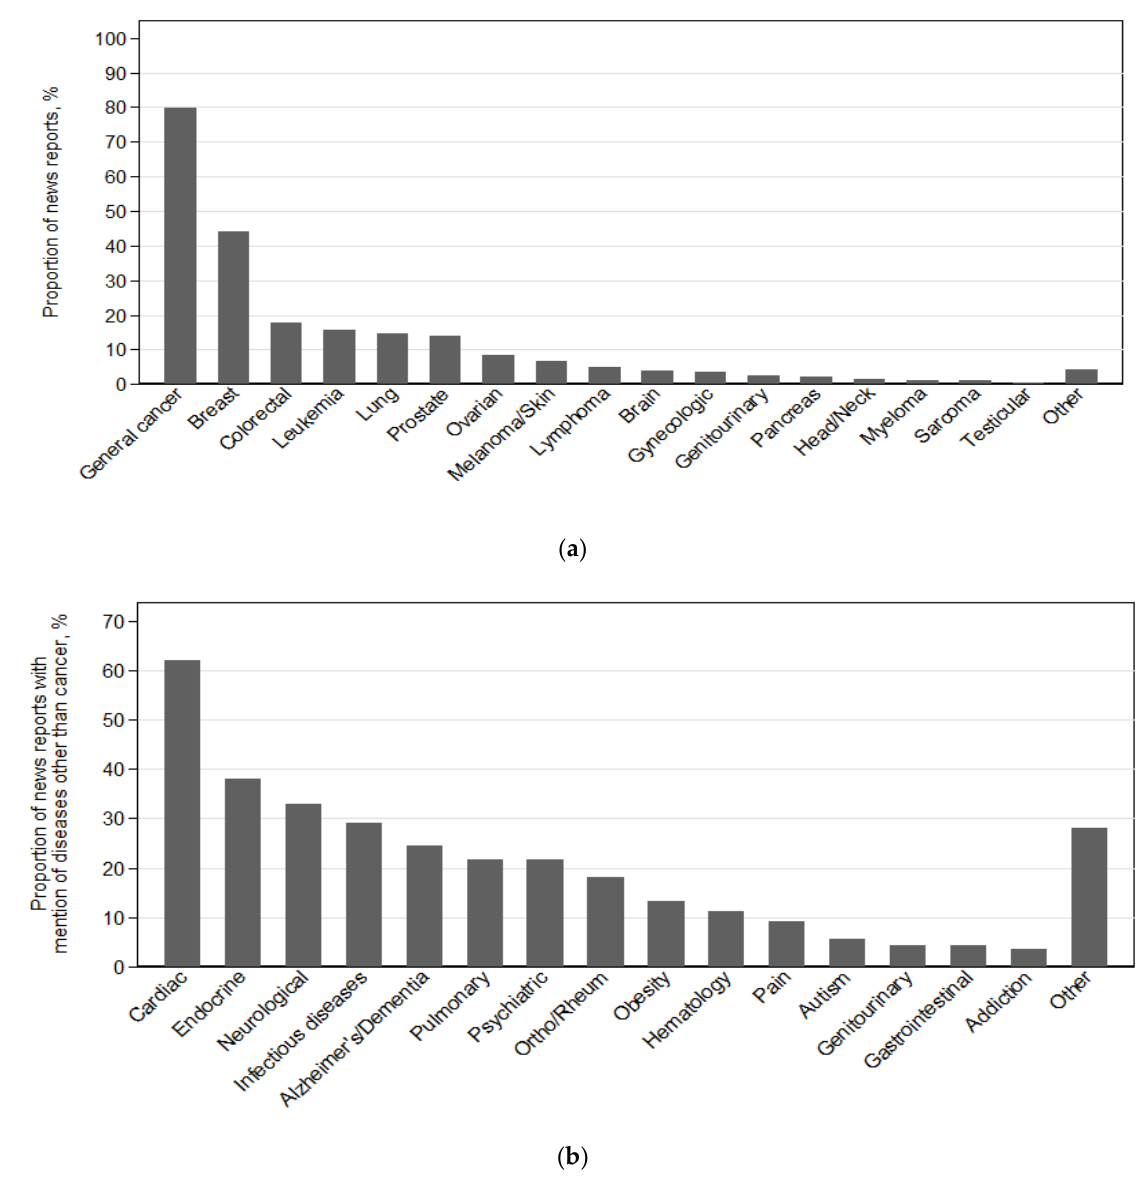
Figure 3. Types of cancer and non-cancer diseases included in media reports about personalized medicine: ( a ) types of cancer reported ( n = 396); ( b ) other diseases reported ( n = 250).